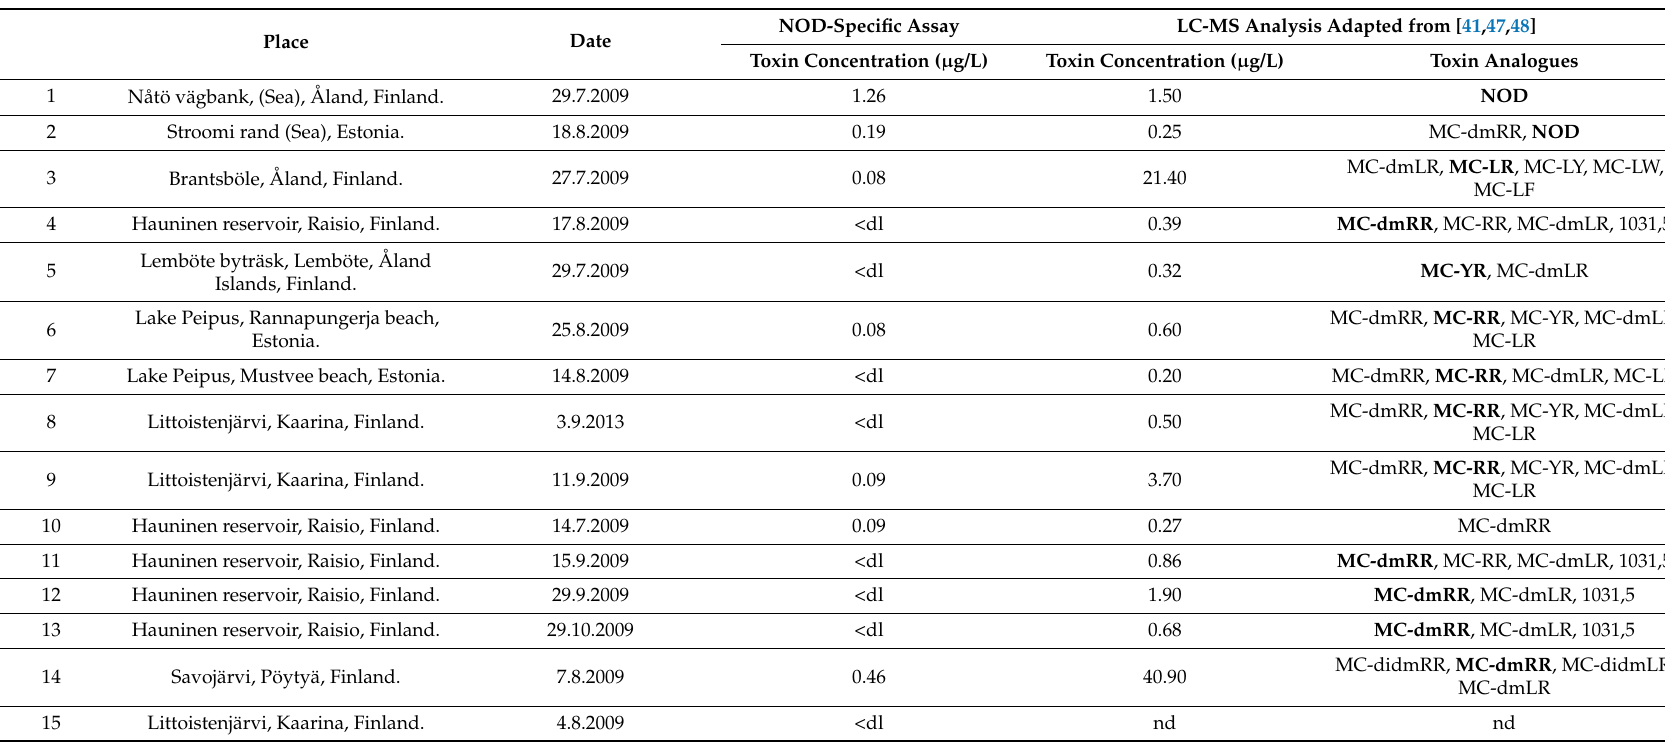
Table 3. Toxin concentration measured by the non-competitive NOD-specific assay (NOD-R equivalent) from the fifteen water samples. The total toxin levels (MC-LR equivalent) and main toxin variants revealed by the previous LC-MS analysis [41,47,48] are also shown. NOD-Specific Assay LC-MS Analysis Adapted from Place Date